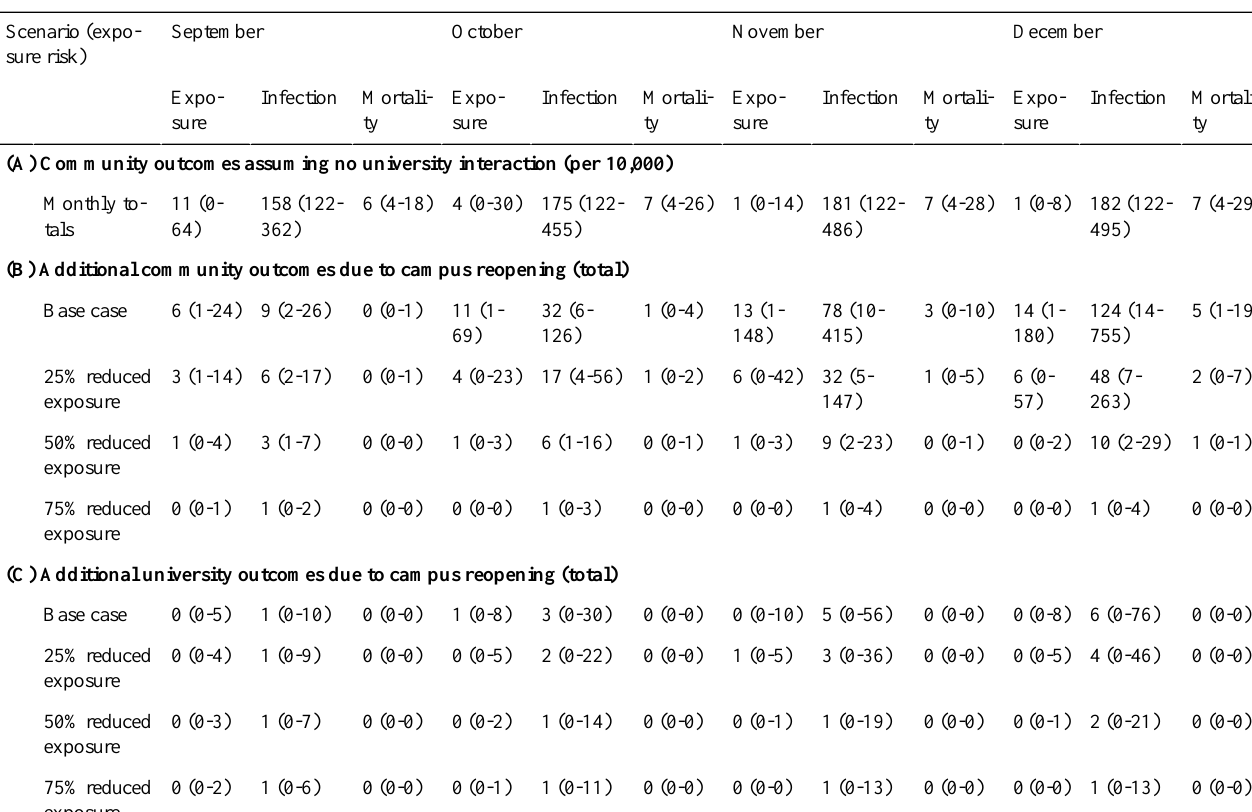
Table 4. Predicted monthly total campus and community COVID-19 outcomes (per 10,000) during the fall 2020 semester. (A) Total community resident outcomes assuming no university interaction, (B) additional community resident outcomes due to campus × community spread, and (C) additional university student outcomes (urban university example). Tabulated values are medians across 1000 replicates; values in parentheses indicate 95% probability